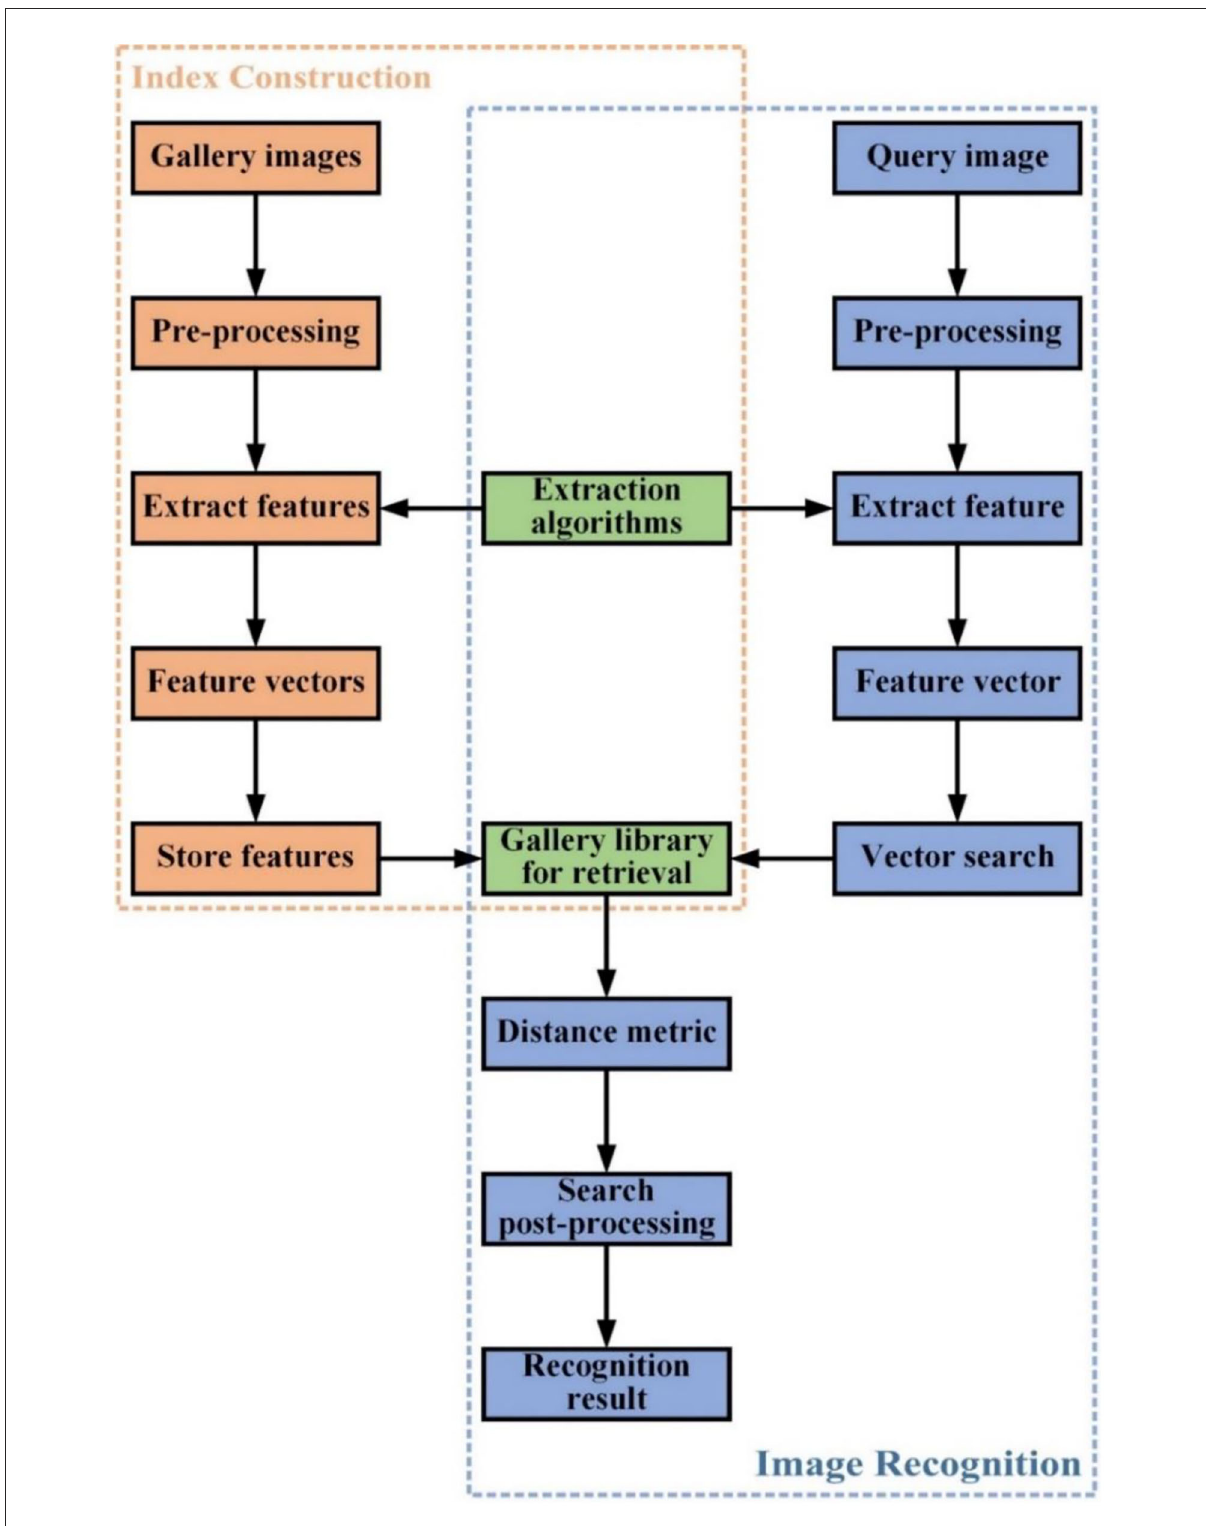
FIGURE2 Workflow of image